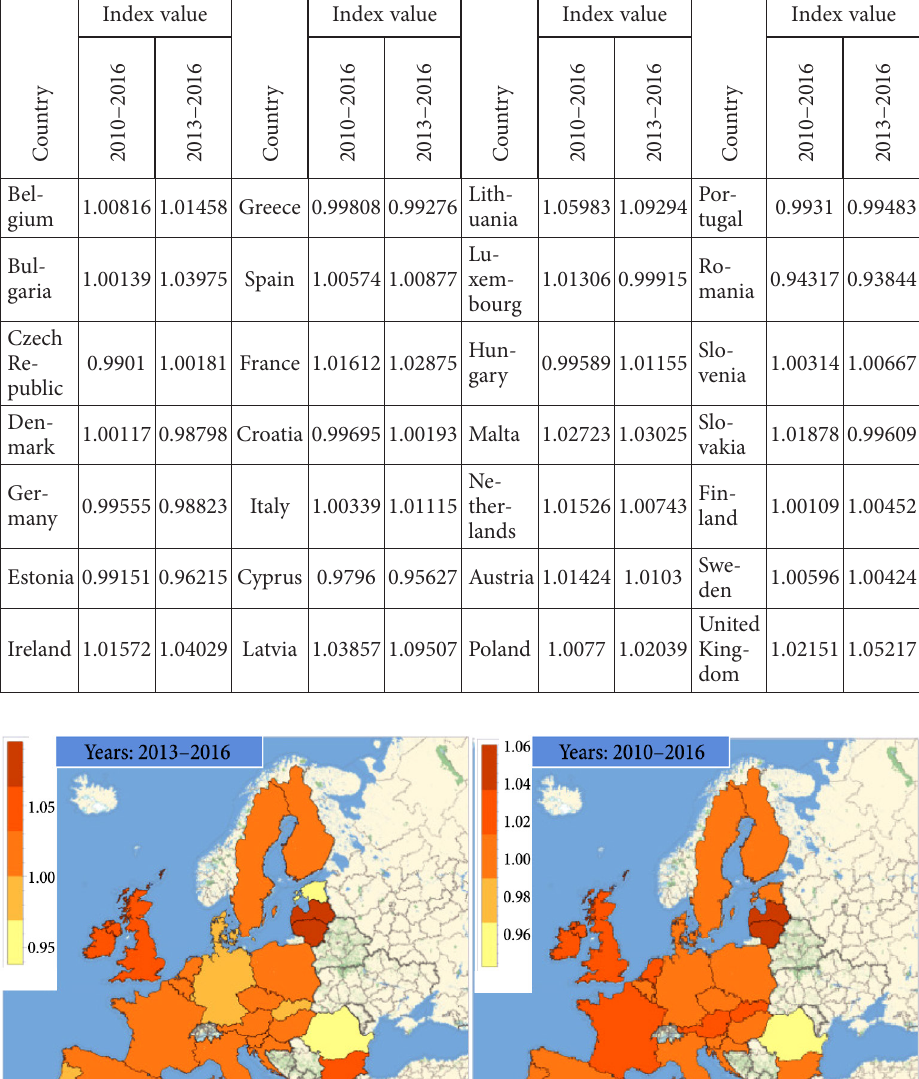
Table 8. The average one-year innovativeness change ( , ) I s t calculated for the EU countries for the in- terval 2010−2016 and 2013−2016 (source: own elaboration based on the data of the European Statistical Office – Eurostat and European Commission, 2018. European Innovation Scoreboard 2018)